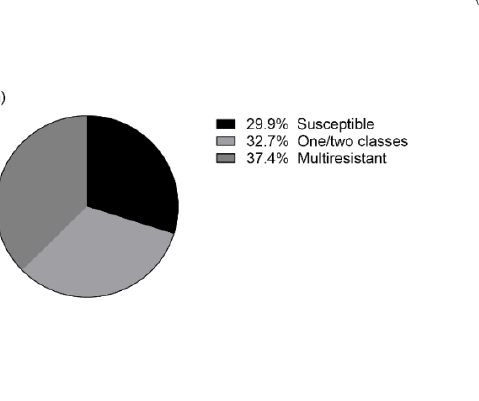
Figure 4. ( a ) Percentage isolates susceptible to all antimicrobials, resistant to one or two classes of antimicrobials and MDR. ( b ) Mean of biofilm formation among isolates susceptible to antimicrobials, resistant to one/two classes and MDR isolates. The red lines represent the average of biofilm mass formed by all isolates. Statistical significance was determined using Tukey’s multiple comparison test (* p < 0.05).